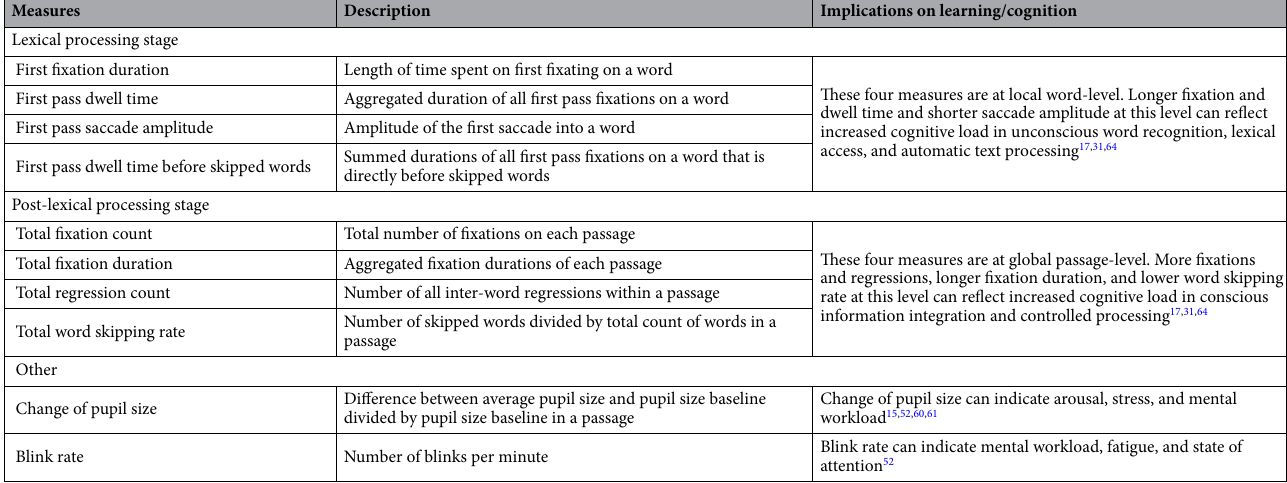
Table 2. Definition of eye-tracking